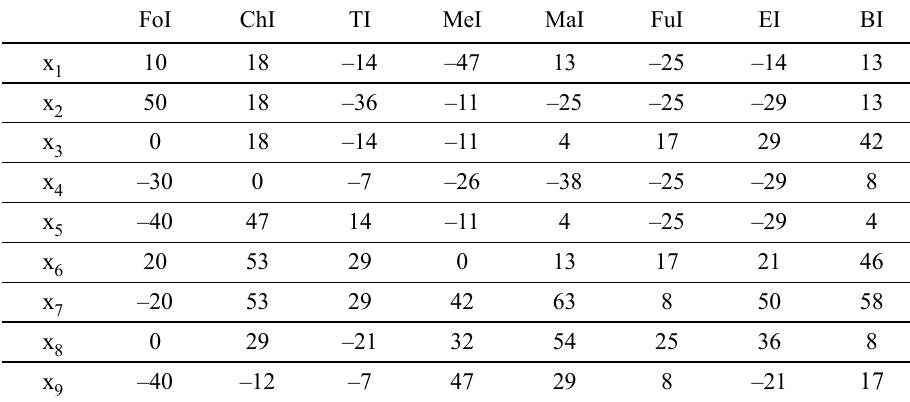
Table B. Relative evaluations for industrial branches